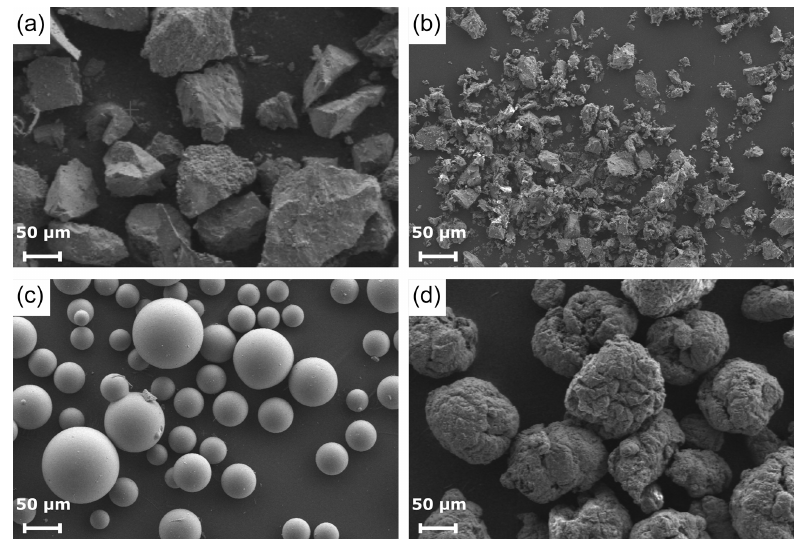
Figure 1. SEM (scanning electron micrograph) pictures of the materials tested in this work. (a) Crushed quartz, (b) silica powder, (c) glass microbeads, (d) PVC powder. Table 2. Geometrical and physical properties of pure granular materials and mixes. Here we show values for grain size ( D 50 ), particle density ( ρ part ), porosity ( γ ), permeability ( k ), cohesion ( C ), and internal friction angle for peak ( φ p wet ) and stable ( φ s wet ) friction. Sphericity and roughness have been estimated after the acquisition of SEM imaging. The subscripts dry and wet indicate whether the tests were made with dry materials or water-saturated